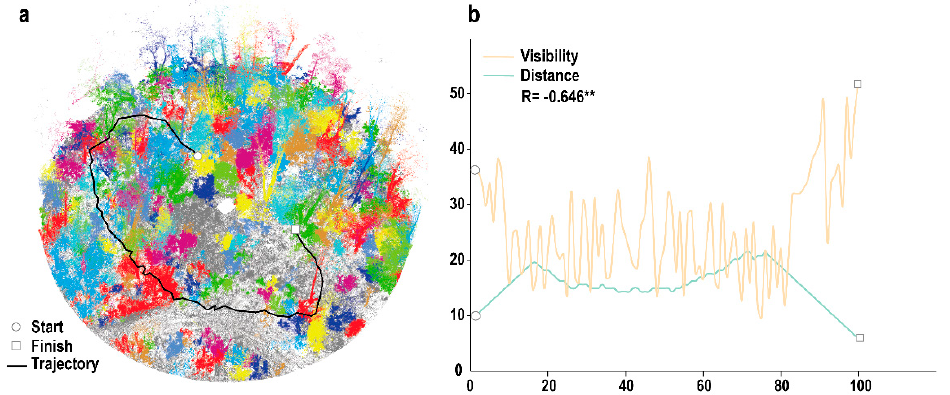
Figure 6. Changes in visibility along the simulated animal trajectories. Point cloud data from the sample of 2021-05-19-09-47-40. ( a ) Simulated animal trajectories in environment point clouds. ( b ) The relationship (R = − 0.646, p < 0.01 **) between the distance from the target and the change of visibility.